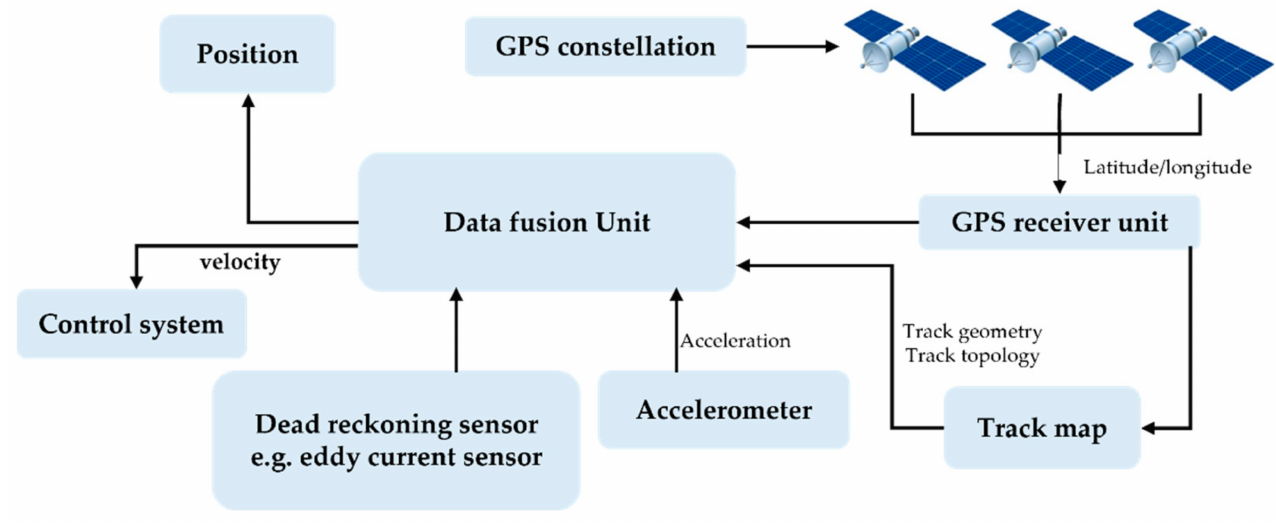
Figure 6. Main components of a railway vehicle positioning. Table 1. Train Positioning Sensor